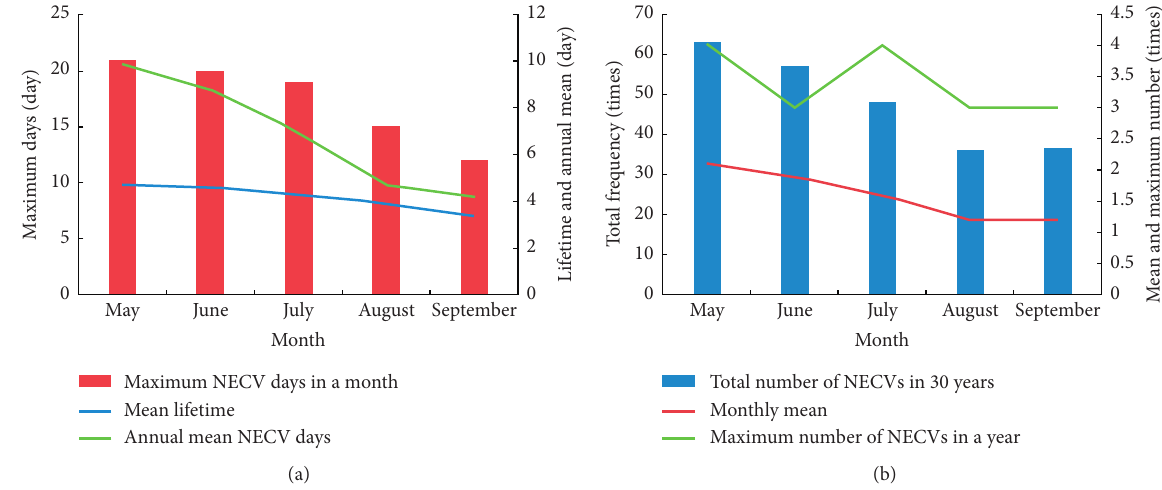
Figure 5: Monthly variations for the numbers of NECV processes: (a) unit: day; (b) unit: times. The left y -axis in (a) represents maximum NECVs days in a month, and the right y -axis in (a) represents mean lifetime and annual mean NECV days; the left y -axis in (b) represents the total number of NECVs in 30 years, and the right y -axis in (b) represents the monthly mean and maximum number of NECVs in a